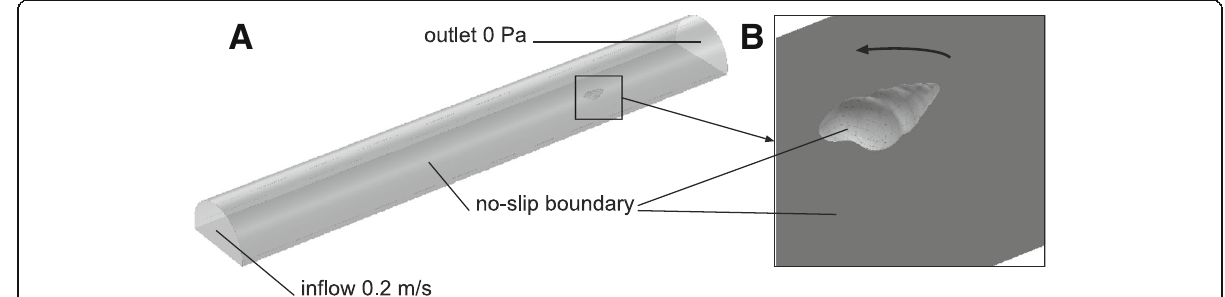
Fig. 2 Experimental setup used for the CFD studies. a semi-circular flow channel resembling the channel with the platform where the snails were placed in the real experiments. Flow was applied from left to right. Beside the inflow and outlet facets of the tank, all boundaries were set to a no-slip condition, i.e. a boundary layer was formed on these faces. b close-up of the shell placed just above the platform. The shell was rotated anticlockwise in the experiments as indicated by the circular arrow